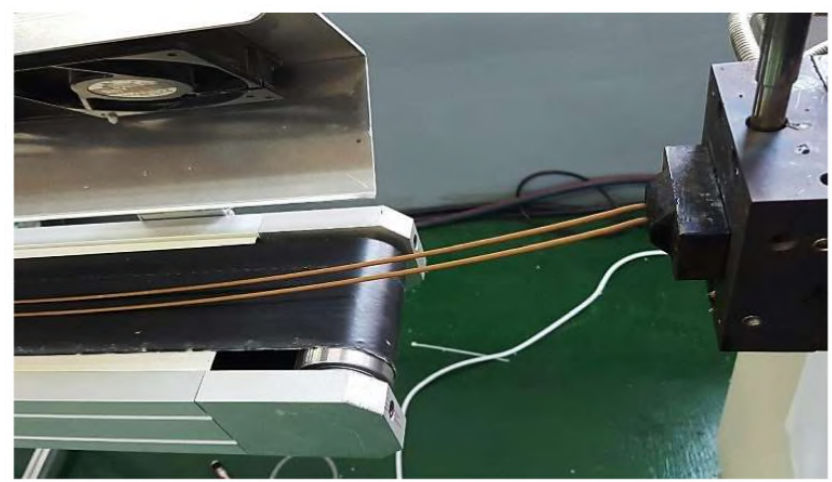
Figure 4. Extrusion compounding process of the wood-plastic composite.